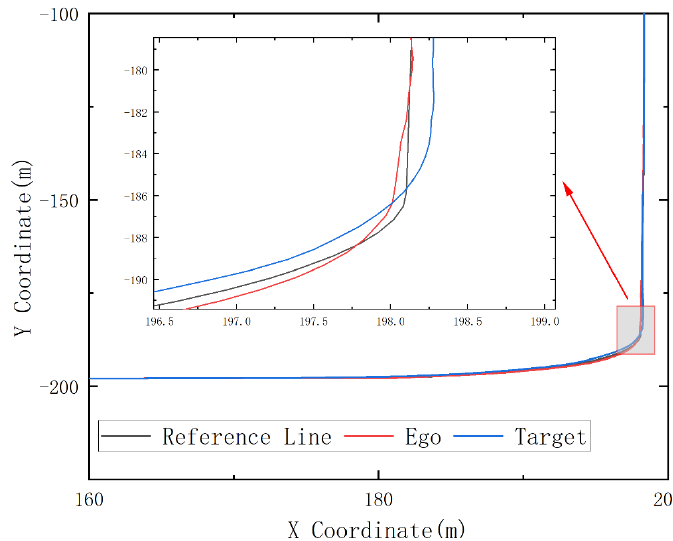
Figure 6. Turning process trajectory comparison chart.